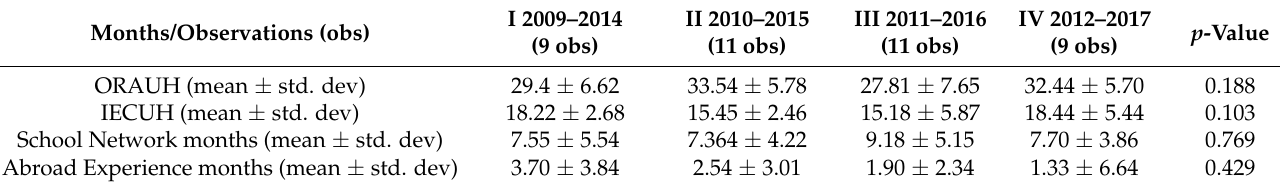
Table 3. Training among school cohorts.